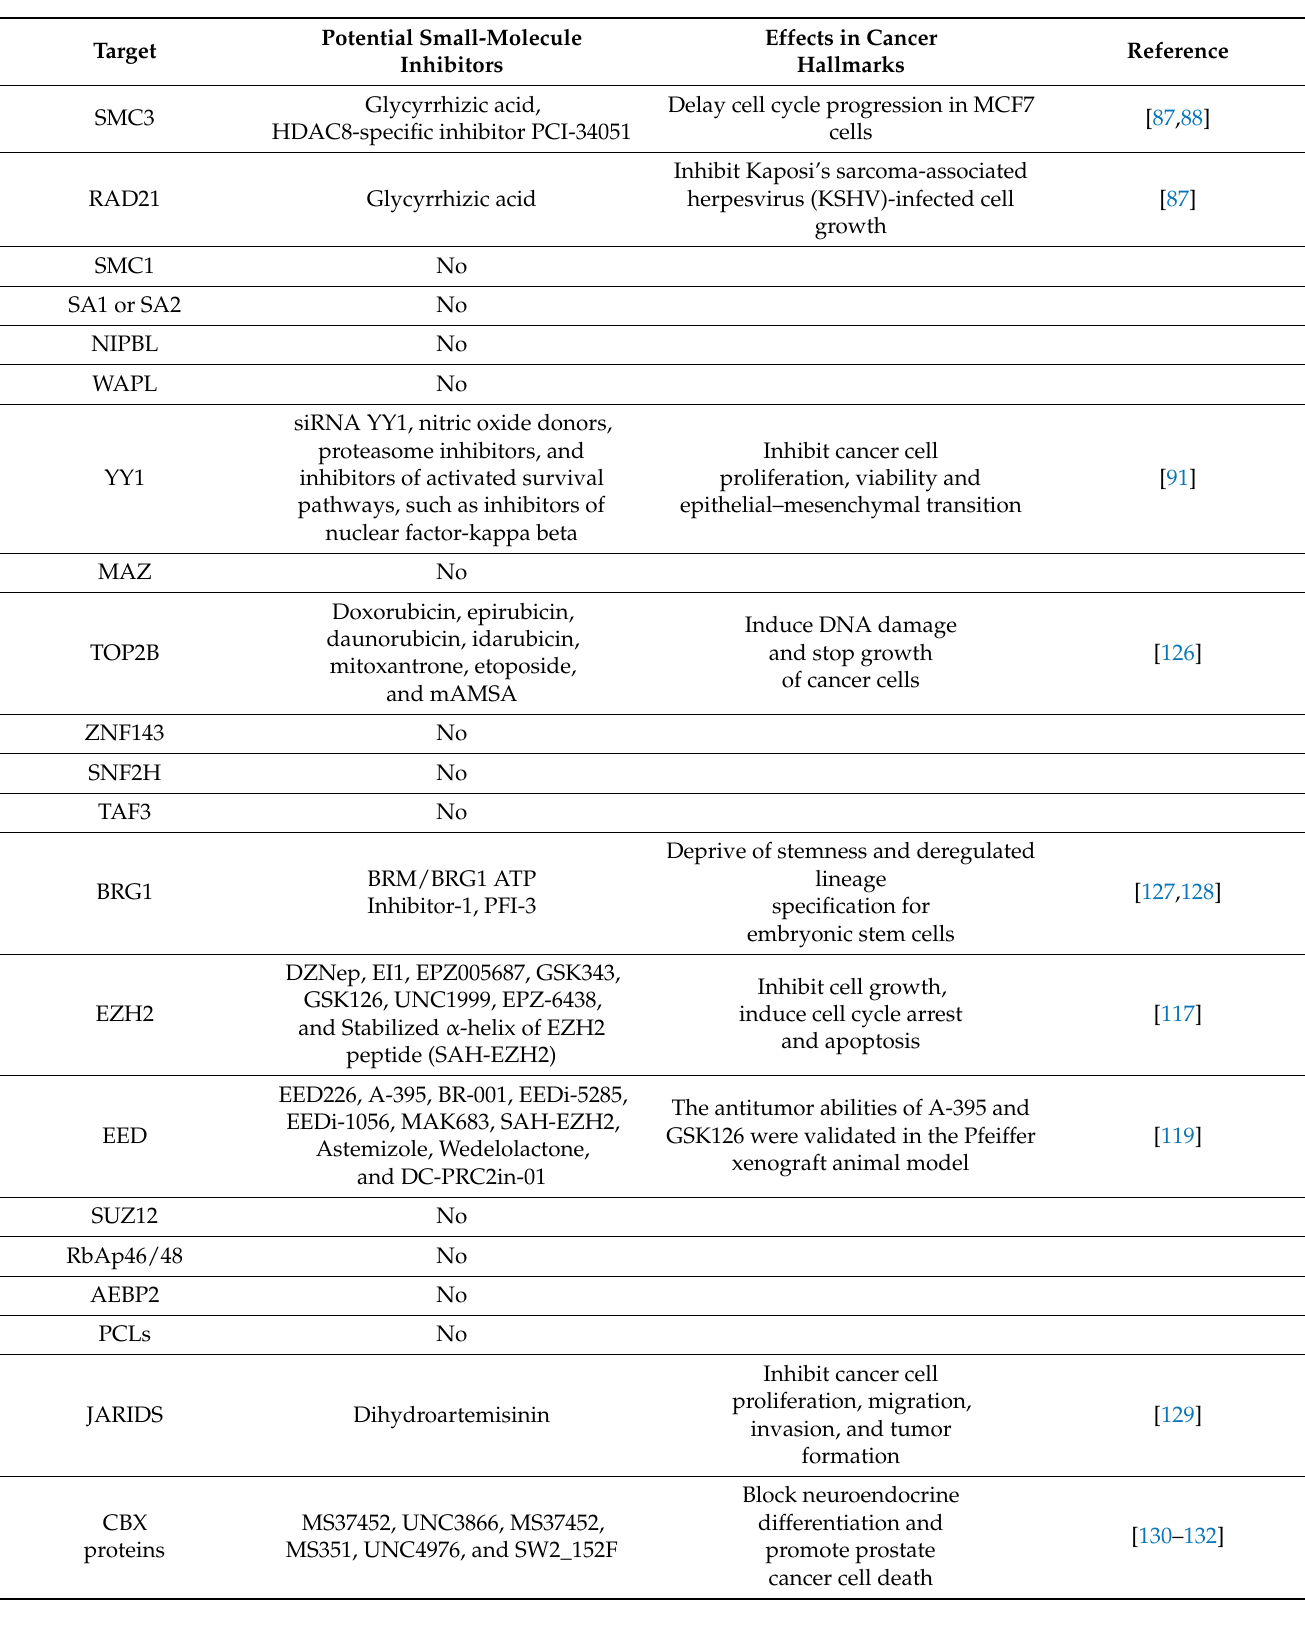
Table 2. Targets and their potential inhibitors of disrupting 3D genome